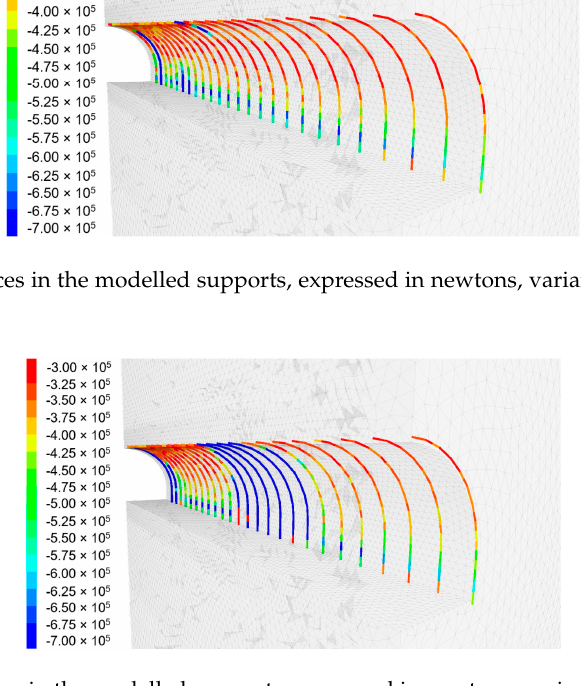
Figure 15. Axial forces in the modelled supports, expressed in newtons, variant II with a variability coefficient of 25%.